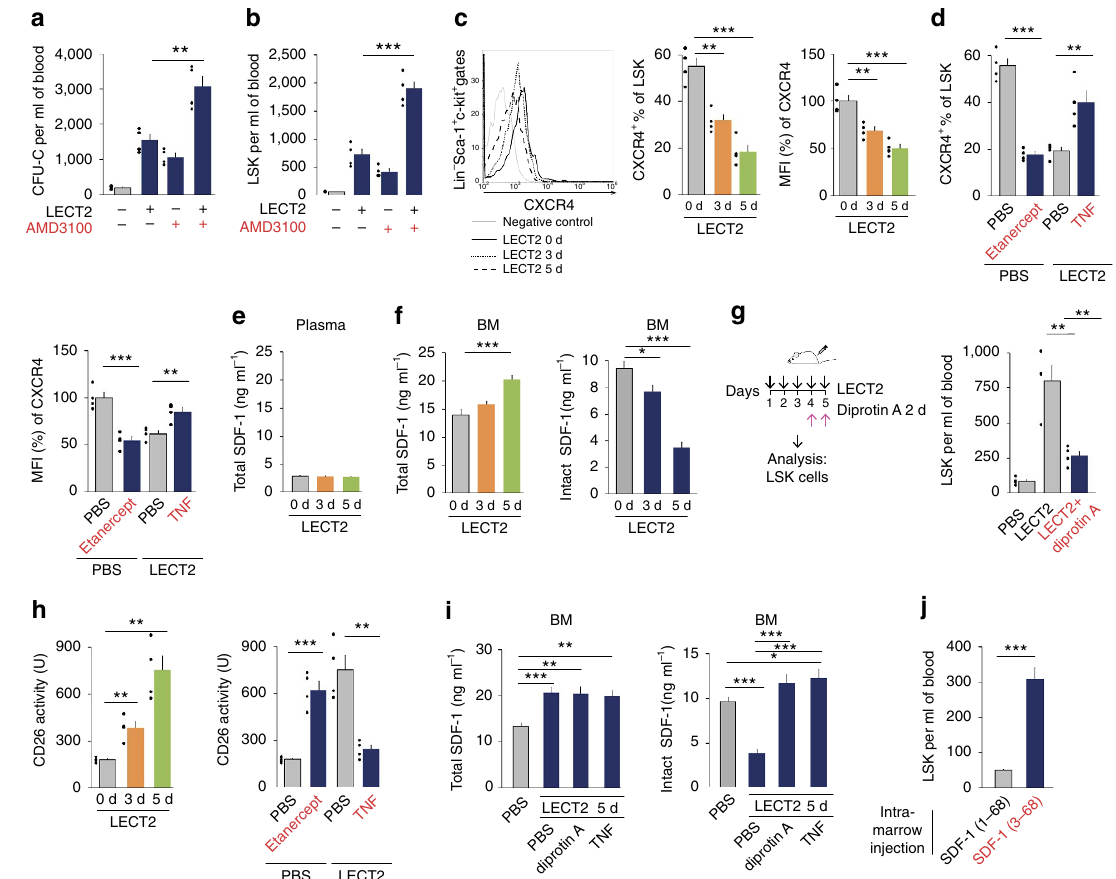
Figure 7 | TNF mediates the effect of LECT2 on the SDF-1-CXCR4 axis. ( a ) Effect of CXCR4 inhibitor (AMD3100) on the number of blood CFU-Cs after LECT2 treatment. ( b ) Quantification of the number of blood LSK cells in mice injected with AMD3100 after LECT2 treatment; n ¼ 4. ( c ) Surface CXCR4 expression on LSK cells from flushed BM cells after LECT2 treatment. n ¼ 4. ( d ) Surface CXCR4 expression on LSK cells from the BM of mice after TNF or etanercept treatment combined with LECT2 induction for 3 days; n ¼ 4. ( e ) SDF-1 protein levels in the plasma of PBS- or LECT2-treated mice; n ¼ 10. ( f ) Total and intact SDF-1 in BM after LECT2 treatment; n ¼ 5. ( g ) The number of LSK cells in the blood were analysed after LECT2 and/or diprotin A treatment. ( h ) CD26 peptidase activity in flushed BM cells after TNF or etanercept treatment combined with LECT2 induction for 3 days; n ¼ 4. ( i ) Total and intact SDF-1 in BM after diprotin A or TNF treatment combined with LECT2 incubation; n ¼ 5. ( j ) The number of LSK cells in the blood was analysed after intra-femur SDF-1 (1–68) or SDF (3–68) injection; n ¼ 5. The small black dots in histograms are data points. The data represent means ± s.e.m. The data are representative of two ( a – d and g – j ) and three ( e , f ) independent experiments. * P o 0.05, ** P o 0.01, *** P o 0.001 using one-way